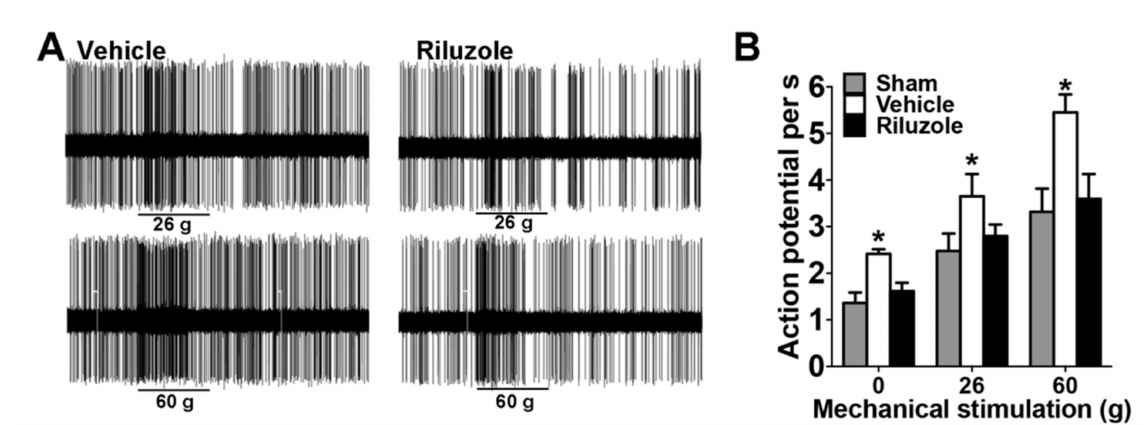
Figure 3. Riluzole suppressed the neural sensitization in ION-CCI rats. ( A ) Representative recordings of ACC mechanical excited neurons in response to graded pressures in anaesthetized CCI rats. ( B ) Local infusion of riluzole into the ACC decreased the neuronal firing rates induced by mechanical stimuli in CCI rats (n = 12 neurons). Statistical significance was determined by two-way ANOVA, followed by multiple comparisons adjusted by the Bonferroni’s test, * p < 0.05, ION-CCI (Vehicle) vs.